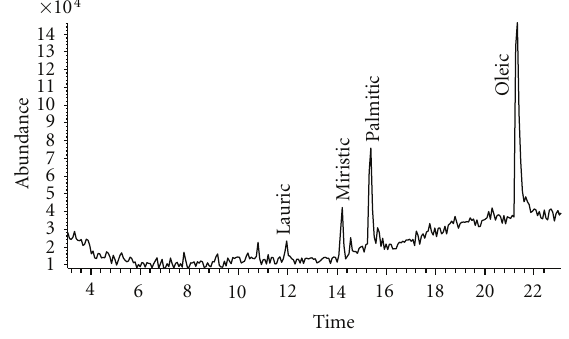
Figure 2: Chromatogram with mass spectrum identification obtained for the free fatty acids of tucum oil-identification of its major oleochemical